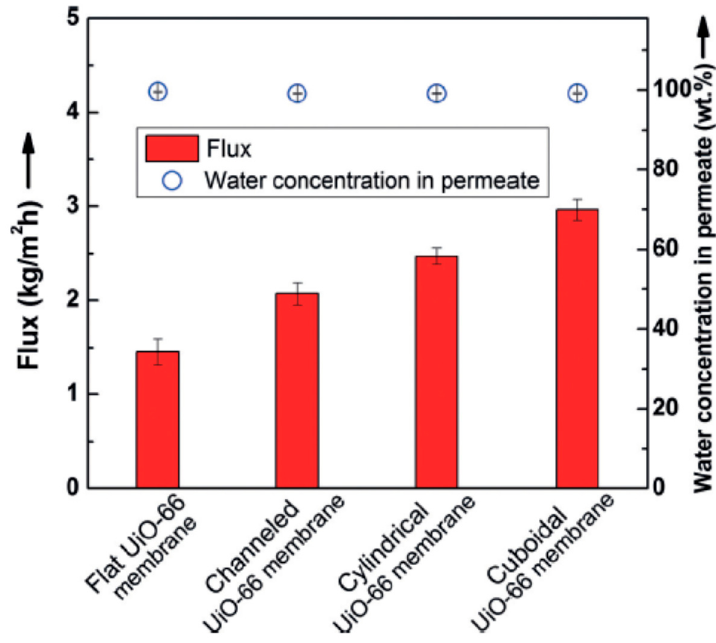
Figure 5. Separation performance of UiO-66 membranes with different patterns; Reproduced with permission from [69].